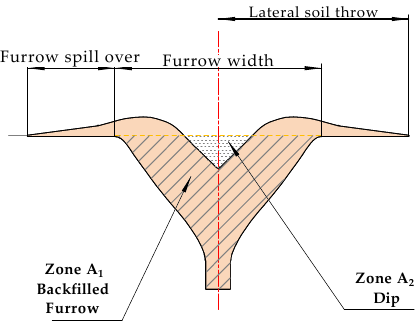
Figure 9. Furrow profile parameters.